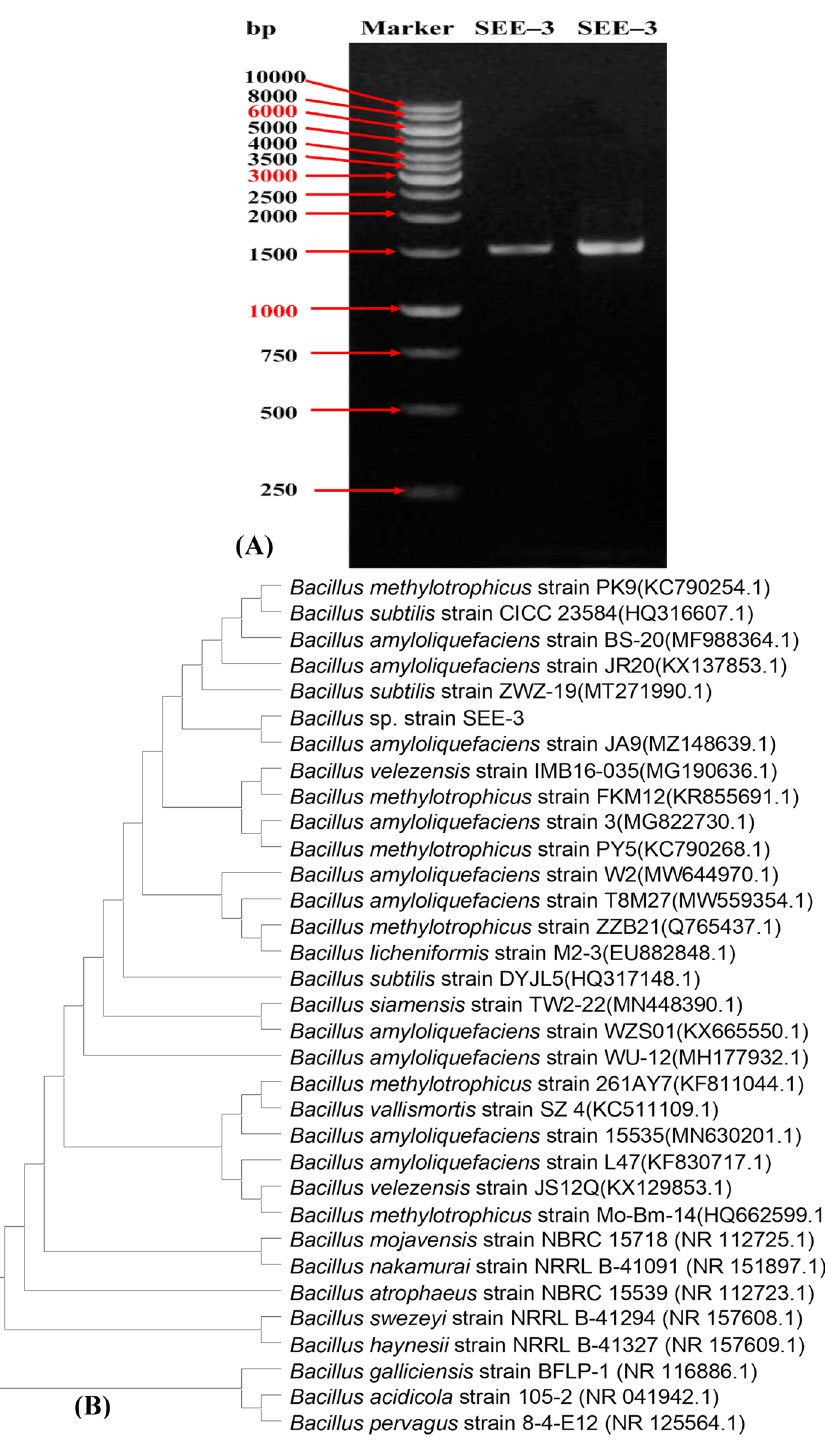
Figure 3. ( A ) Agarose gel electrophoresis showing the PCR product of the amplified 16S rRNA fragment for the strain SEE-3. ( B ) The phylogenetic tree of strain SEE-3 and related species of the genus Bacillus . ( B ) was created by using MEGA version X